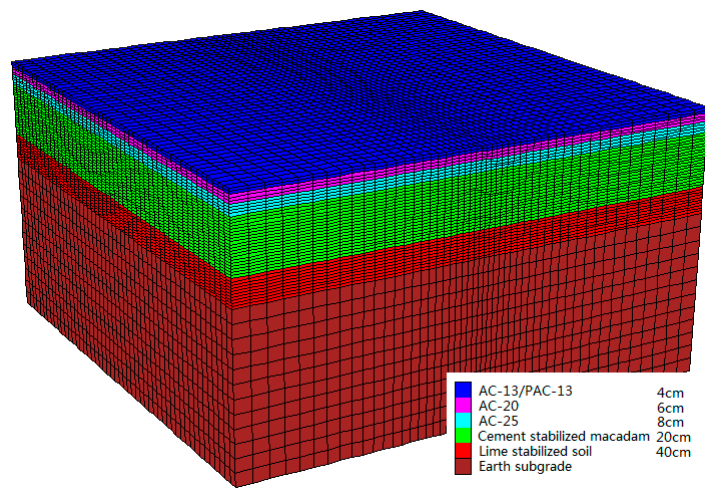
Figure 6. Pavement model in ABAQUS.